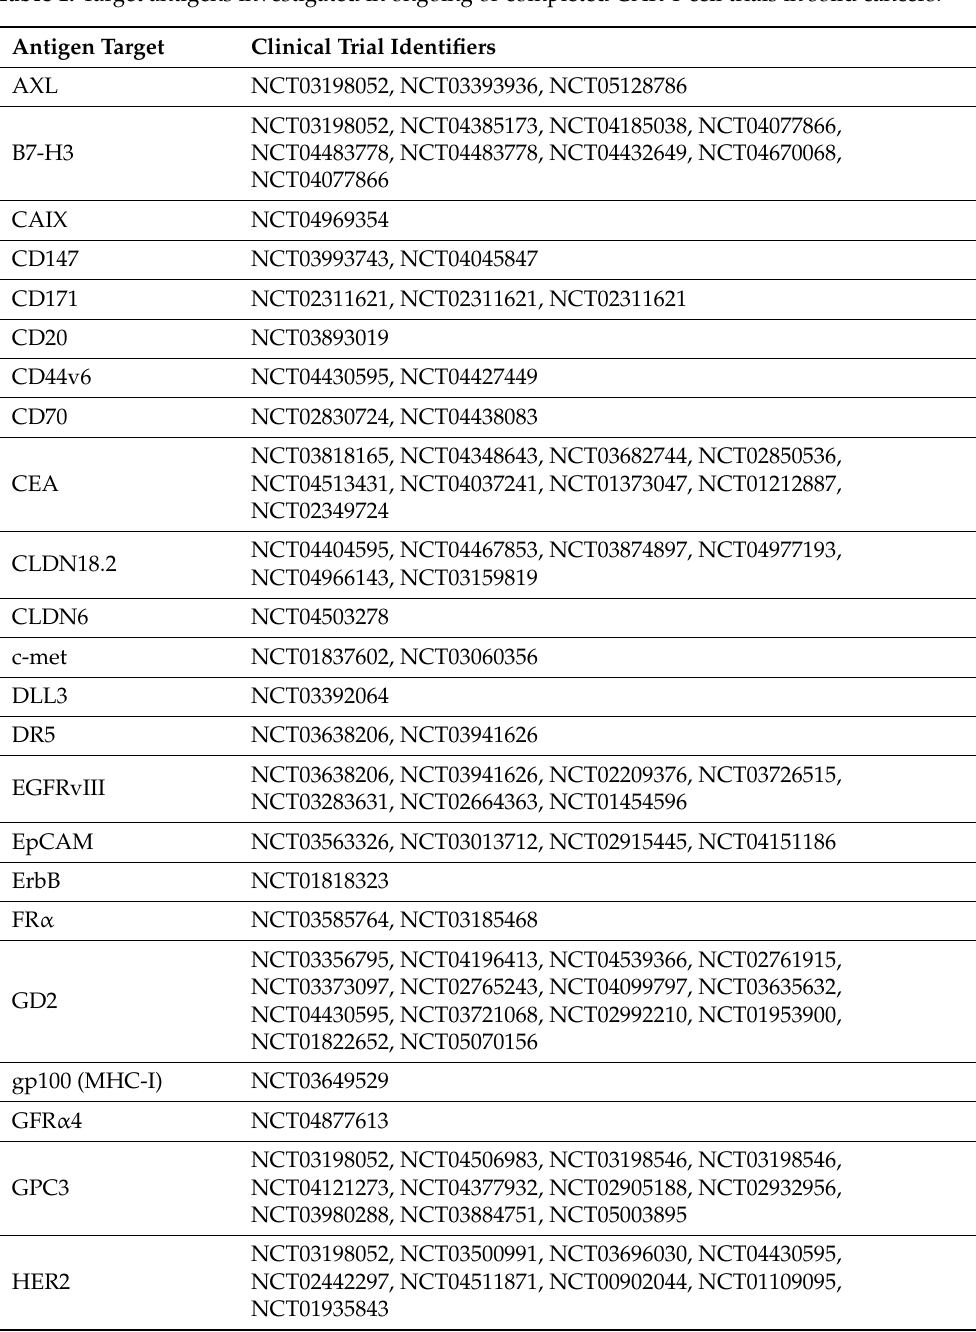
Table 1. Target antigens investigated in ongoing or completed CAR T cell trials in solid